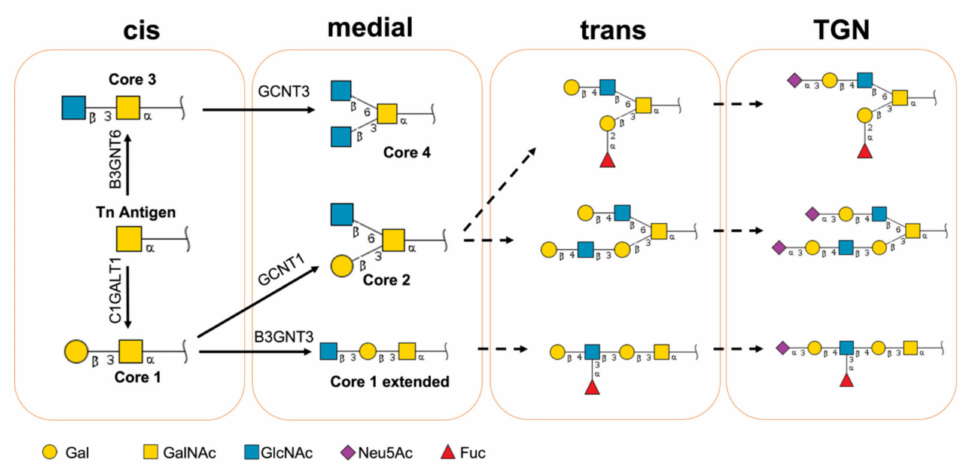
Figure 1. Mucin-type O -glycan biosynthesis pathways. Structures are depicted using the Sym- bol Nomenclature for Glycans (NSFG) symbol nomenclature (yellow square = GalNAc, yellow circle = Gal, blue square = GlcNAc, red triangle = Fuc, purple diamond = sialic